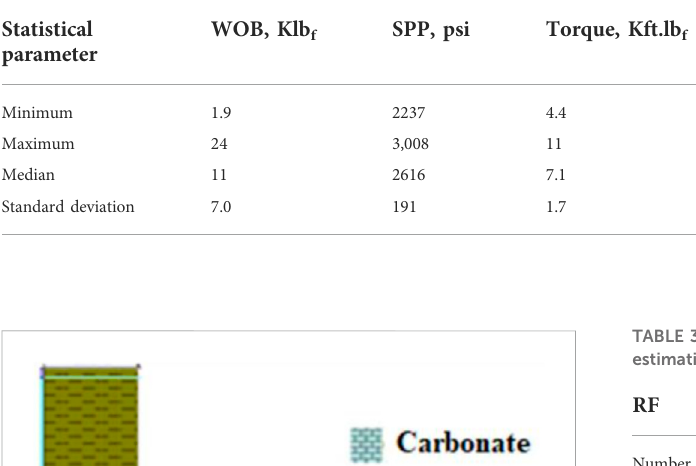
TABLE 2 Statistical parameters for the training